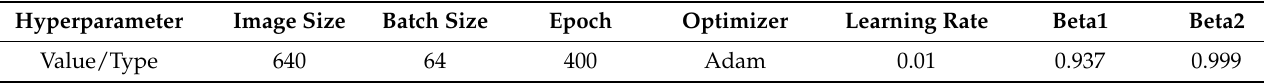
Table 4. Hyperparameter settings applied in the